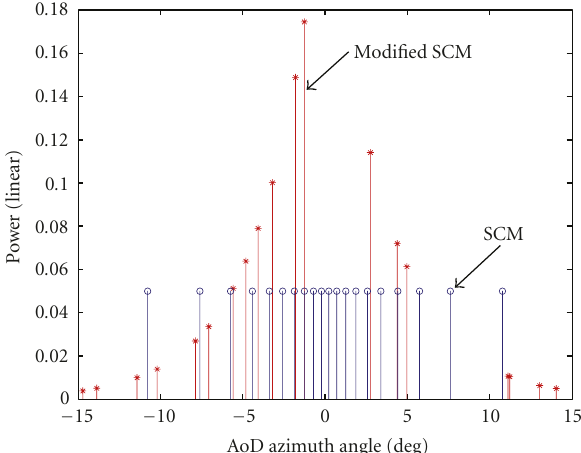
Figure 5: Laplacian PAS with 5degrees RMS AS with basic and modified SCM.